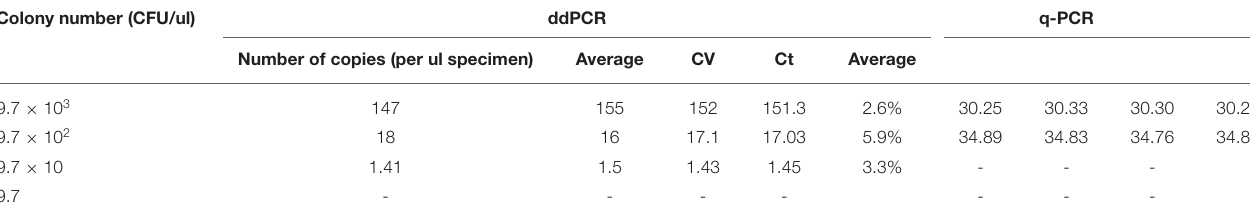
TABLE 3 | Comparison of q-PCR and ddPCR using spiked stool samples with C. botulinum type B strain. Colony number (CFU/ul)